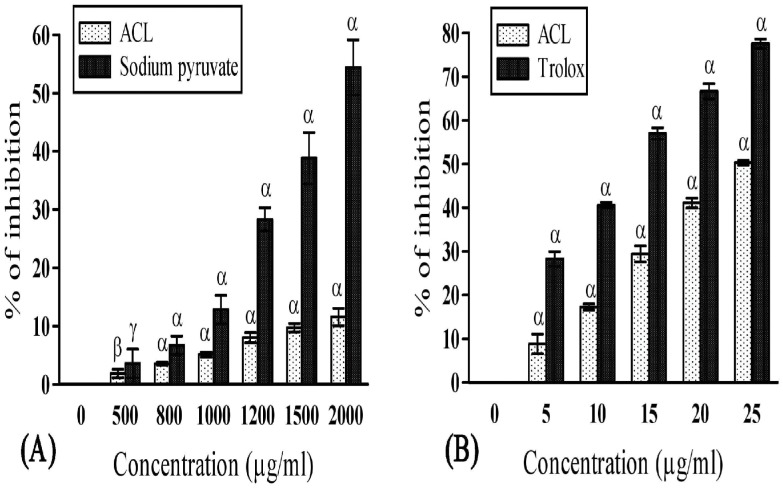
Hydrogen peroxide scavenging and lipid peroxidation inhibitory activity of ACL extract and the reference compound.(A) Hydrogen peroxide (H2O2) scavenging activities of ACL extract and standard sodium pyruvate (IC50 value: ACL = 15604.93±613.81μg/ml and sodium pyruvate = 3176.40±140.22μg/ml; p<0.001). (B) Inhibition of lipid peroxidation by ACL extract and standard trolox (IC50 value: ACL = 32.13±0.99μg/ml and trolox = 11.11±0.22μg/ml; p<0.001). [Each value represents mean ±SD (n = 6); Where, α = p<0.001, β = p<0.01 and γ = p<0.05 Vs 0 μg/ml.].